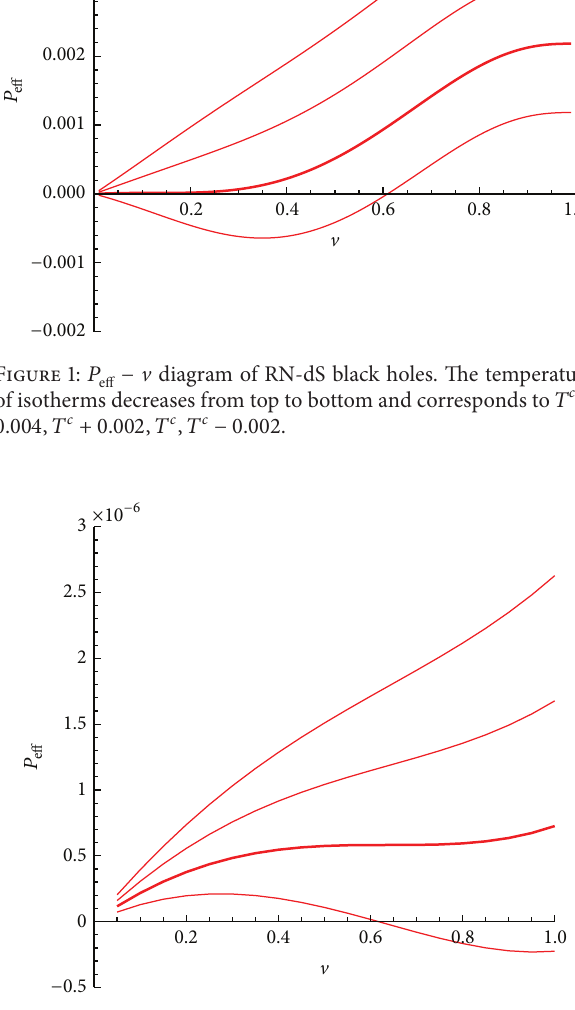
− V diagram of RN-dS black holes. The temperature Figure 2: 𝑃 eff of isotherms decreases from top to bottom and corresponds to 𝑇 𝑐 + 0.00004 , 𝑇 𝑐 + 0.00002 , 𝑇 𝑐 , 𝑇 𝑐 − 0.00002